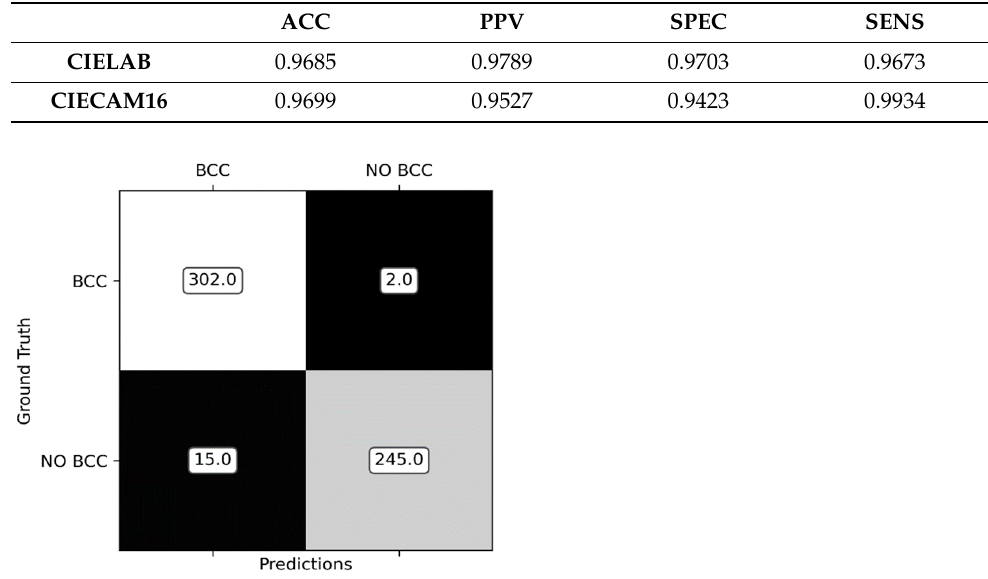
Figure 8. Confusion matrix of the classification into BCC versus non-BCC.